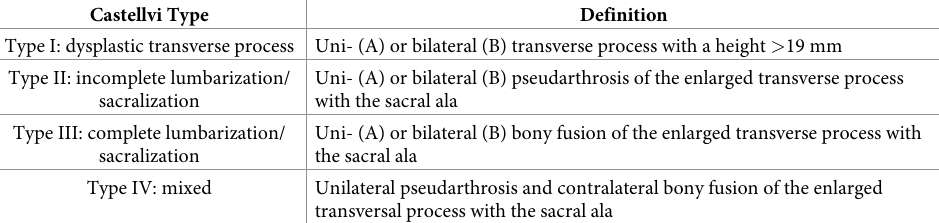
Table 1. Radiographic classification for lumbosacral transitional vertebrae (LSTV) according to Castellvi